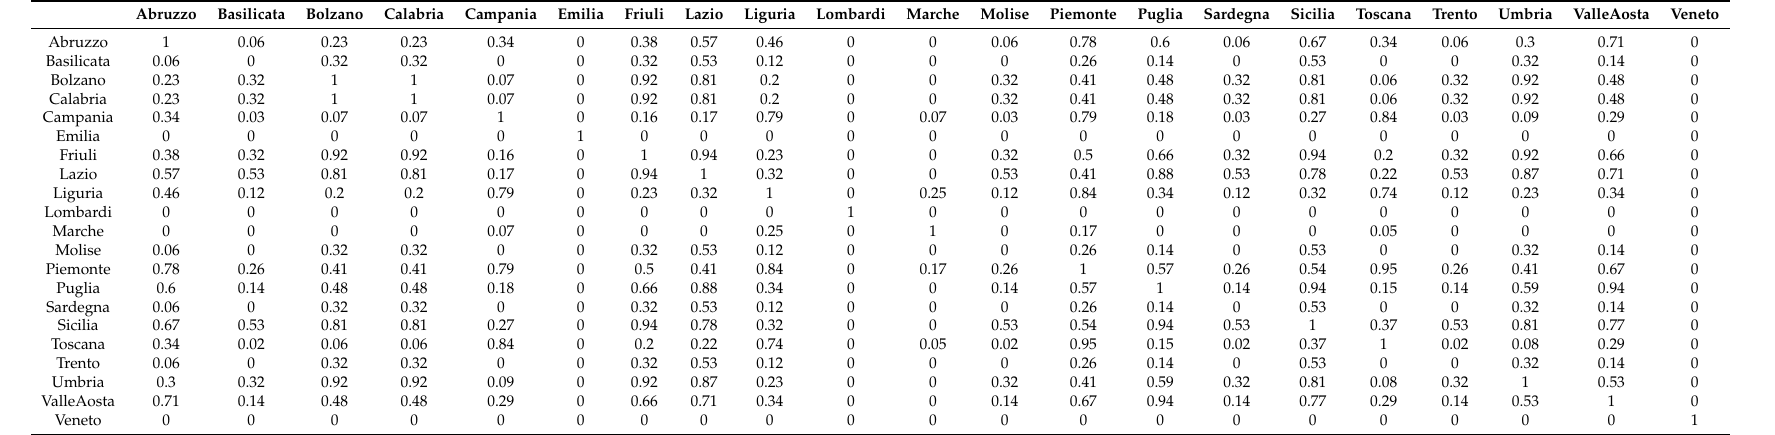
Table A32. Similarity values of New Currently Positive network in the first